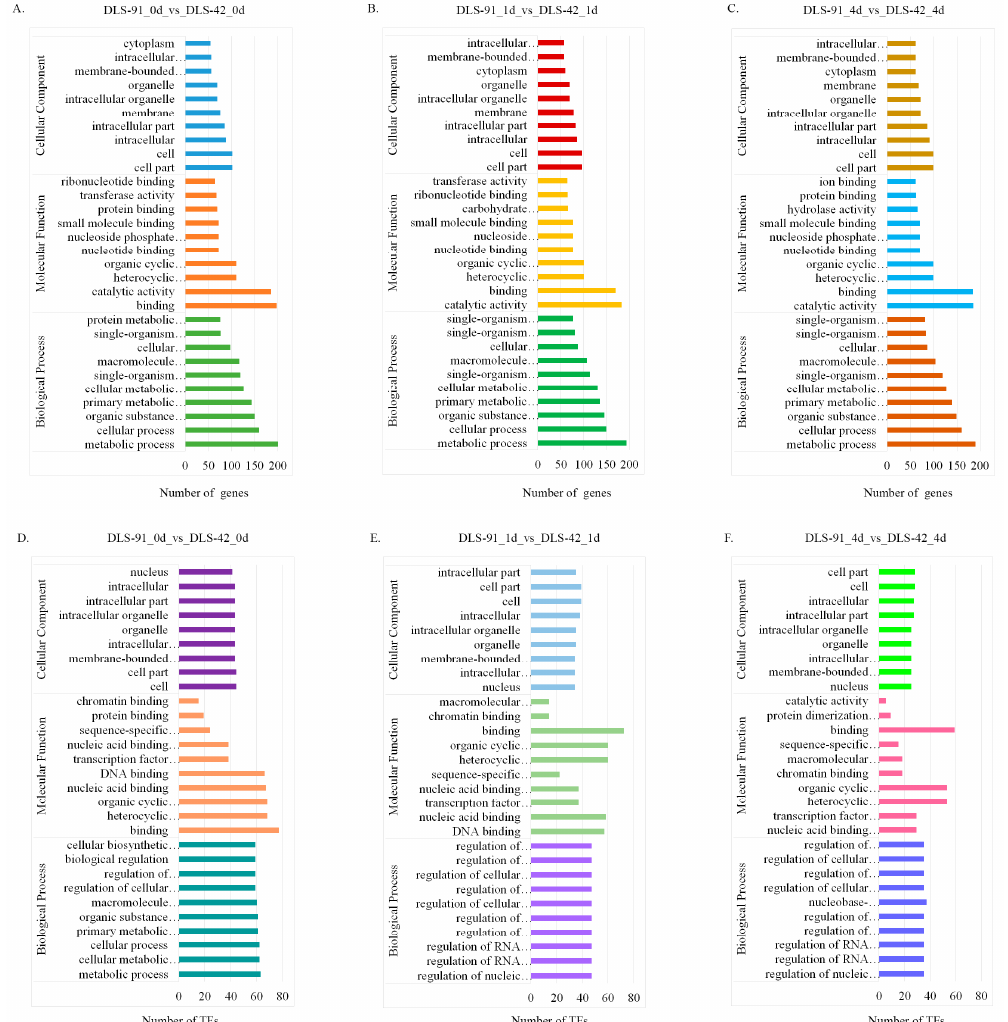
Figure 5. Gene ontology classification of differentially expressed genes (DEGs) and transcription factors (TFs) identified in DLS-42 and DLS-91 leaf samples subjected to 0, 1, and 4 days of dark treatment. ( A – C ) DEGs. ( D – F ) TFs. The number of DEGs and TFs assigned to different GO terms in biological process, cellular component, and molecular function categories using the agriGO online database are shown. To identify pathways associated with genes upregulated and downregulated at each leaf senescence stage, we performed a KEGG pathway enrichment analysis on the entire set of DEGs (Table S8). As a result, genes upregulated at 0, 1, and 4 DDT were assigned to 67, 48, and 59 pathways, respectively. Most of these genes were involved in metabolic and by glycoly- sis/gluconeogenesis and DNA replication-related pathways. In addition, a few genes differentially expressed at 0 and 1 DDT were related to terpenoid and chlorophyll bio- synthesis. Similarly, several DEGs at 1 and 4 DDT were involved in fatty acid biosynthe-